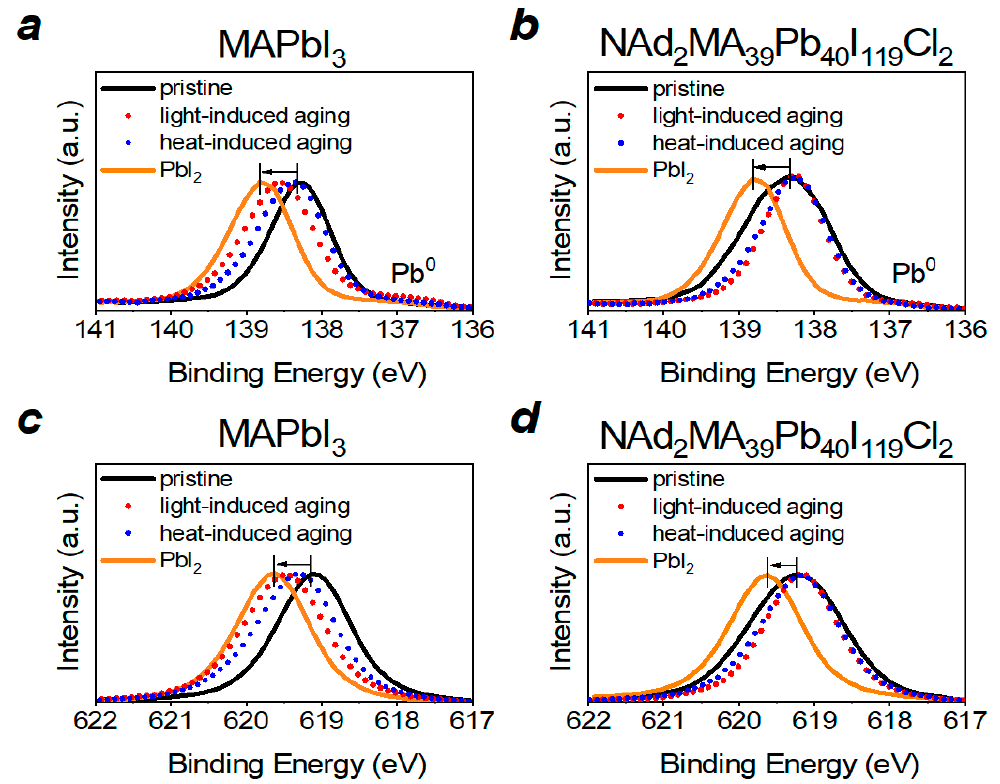
Figure 4. The ( a , b ) Pb 4f 7/2 and ( c , d ) I 3d 5/2 spectra of pristine and thermally and photochemically aged samples of ( a , c ) MAPbI 3 and ( b , d ) NAd 2 MA 39 Pb 40 I 119 Cl 2 .